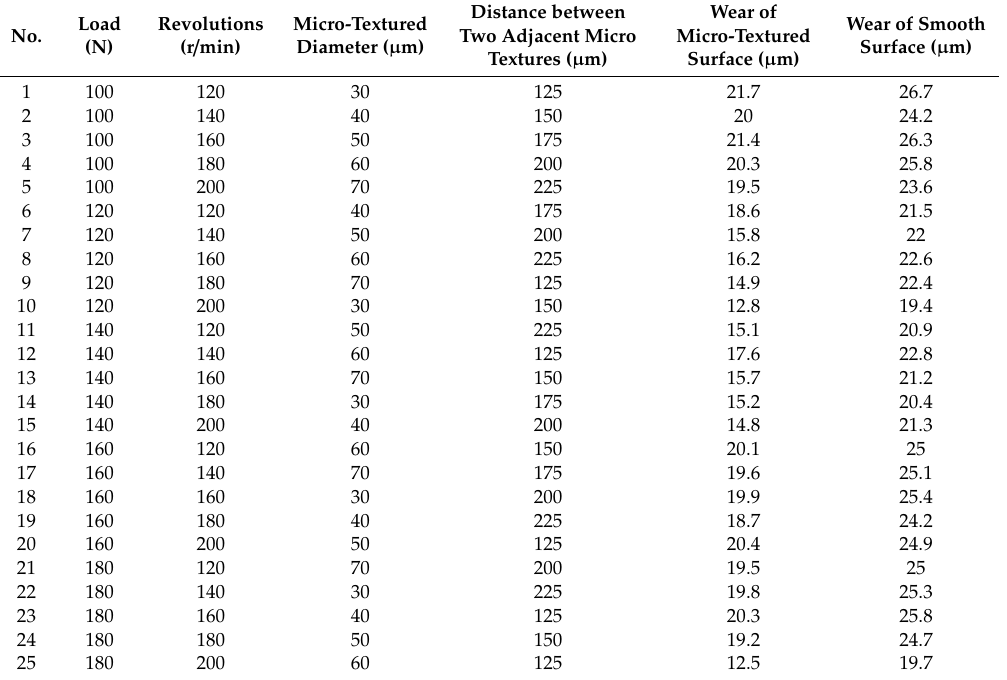
Table 5. Comparison of wear